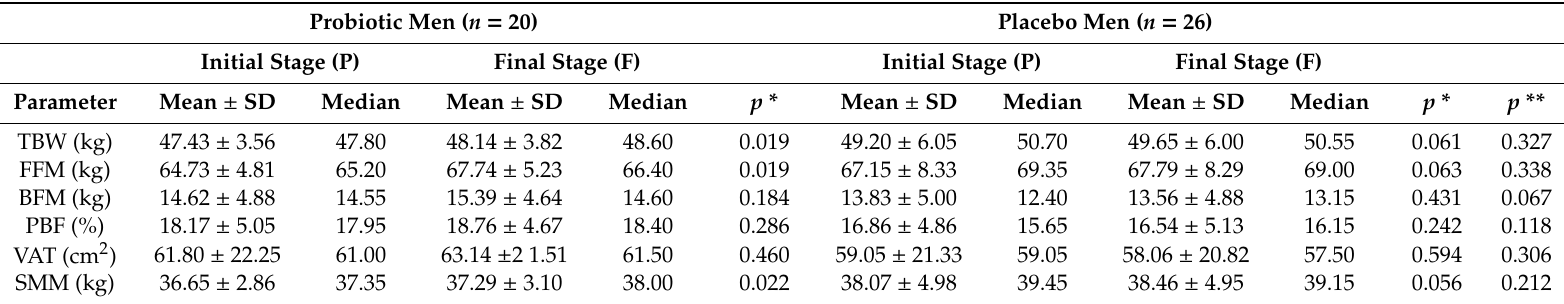
Table 2. Comparison of body composition variables of men from the study and control groups at the initial and final stages of intervention. Probiotic Men ( n = 20) Placebo Men ( n =